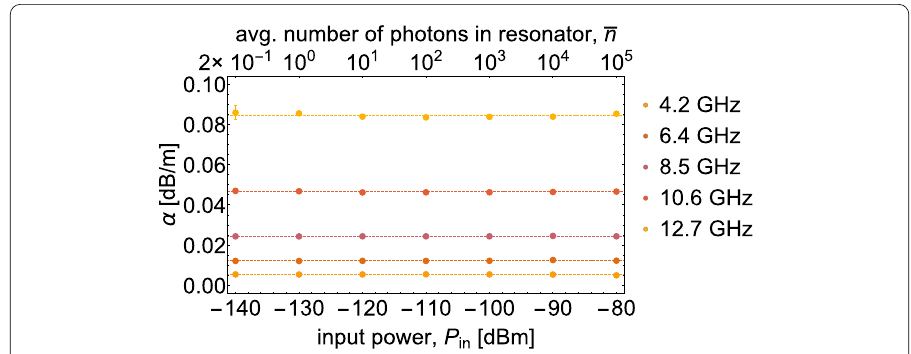
Figure 9 Power dependence of the attenuation constant of niobium-titanium coaxial line CC085NbTi. Attenuation constant α (dots) versus input power at the waveguide P in measured for frequencies between